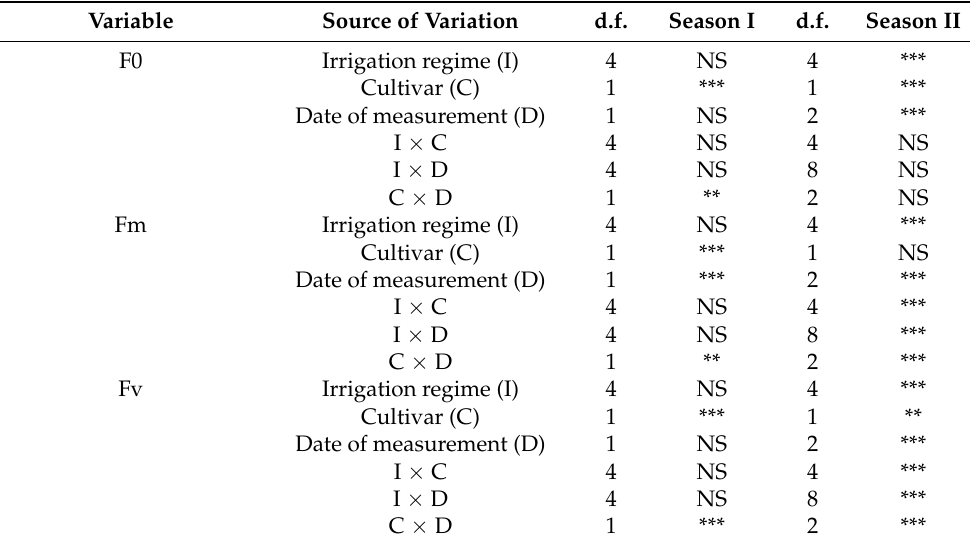
Table 2. Summary of statistical significance from analysis of variance (ANOVA) for the eco- physiological